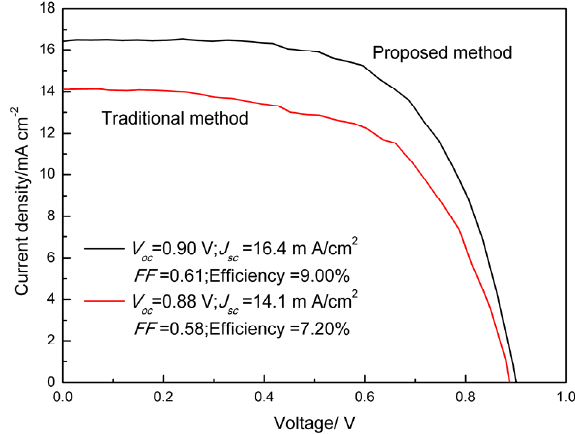
Figure 7. J-V curve of the CH 3 NH 3 PbI 3 /TiO 2 composite thin film prepared with the proposed method and the traditional two-step spin-coating method.